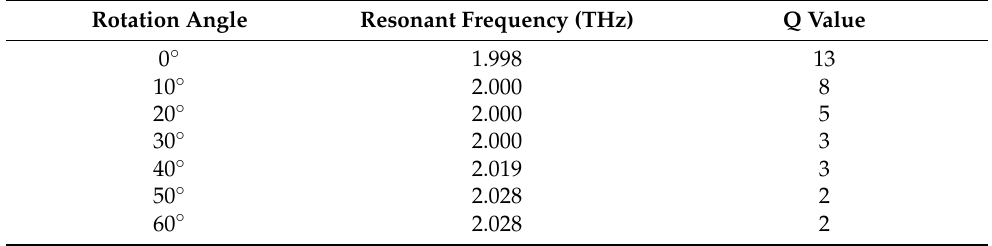
Table 2. Resonant frequency and Q value of the metamaterial sensor with different rotation angles. Rotation Angle